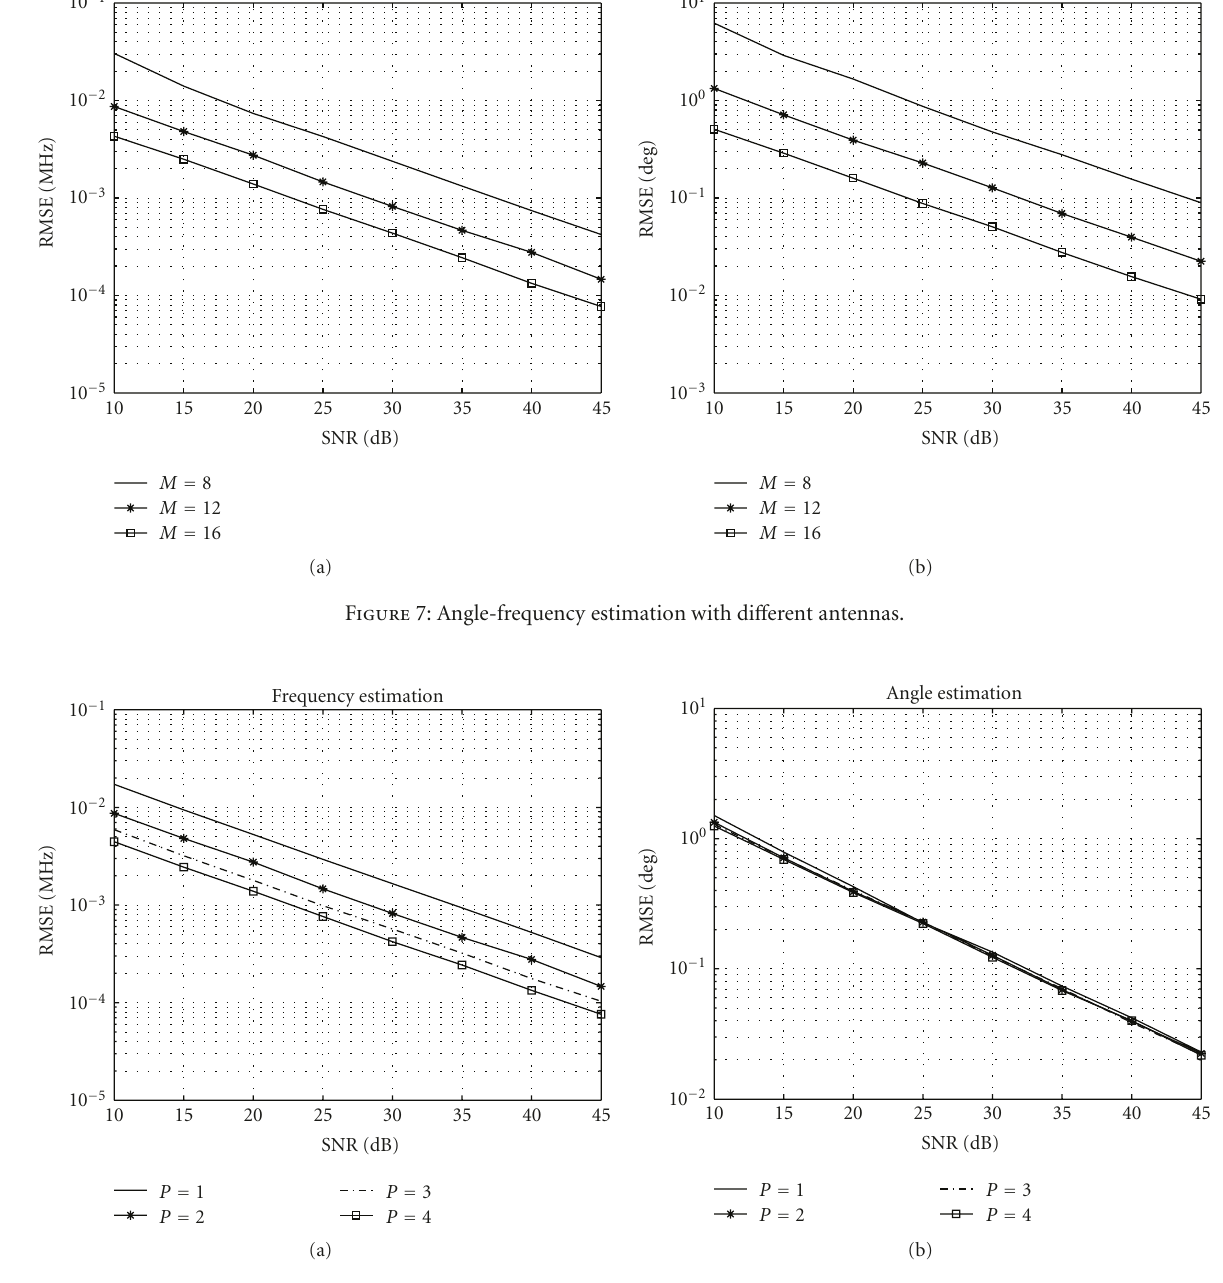
Figure 8: Angle-frequency estimation with di ff erent delay